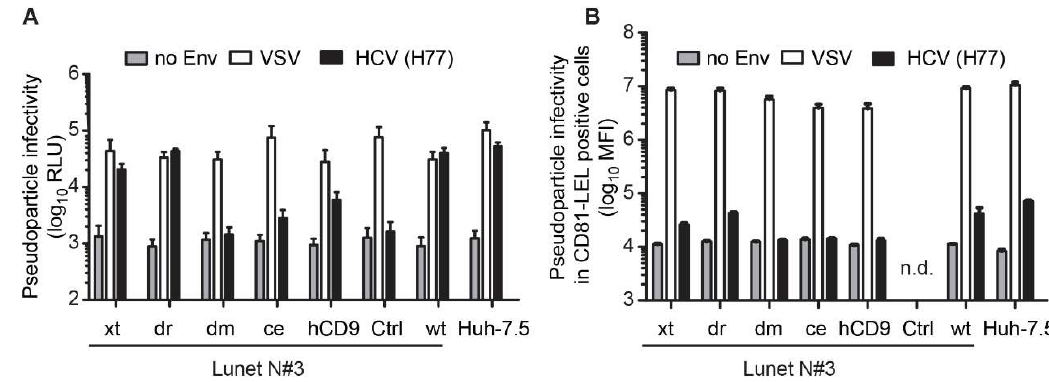
Figure 5. The hCD81 backbone influences HCV pseudoparticle infectivity. ( A ) Chimera expressing Lunet N#3 cells and Huh-7.5 cells were transduced with lentiviral pseudoparticles encoding Firefly luciferase and displaying the glycoproteins of HCV (strain H77) or VSV. Pseudoparticles without glycoproteins (no Env) served as negative control. Pseudoparticle infectivity was measured at 72 hpt by quantitation of luciferase activity; ( B ) Infectivity of GFP encoding lentiviral pseudoparticles displaying HCV (H77) glycoproteins, VSV glycoproteins, or no glycoproteins in chimera expressing Lunet N#3 cells and Huh-7.5 cells. At 72 hpt cells were counterstained with anti-hCD81 antibody, and infectivity of lentiviral GFP pseudoparticles in the hCD81 LEL positive subpopulations quantified. n.d., not detected, i.e., CD81 positive cells below 1000 counts. All experiments were performed at least thrice and are represented as mean + SD of three independent biological replicates ( A ) or technical triplicates ( B ).